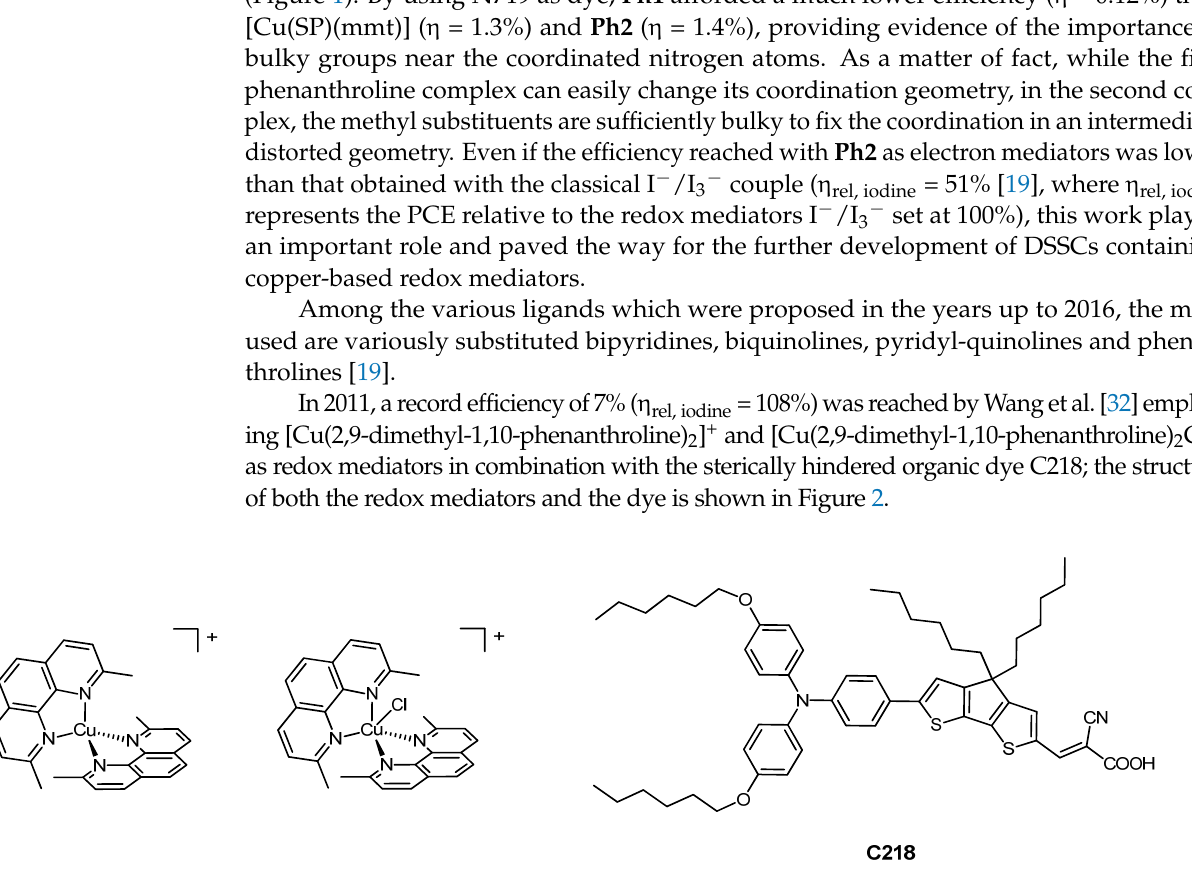
Figure 2. The copper-based electron shuttles and the organic dye C218 used by Wang et al.